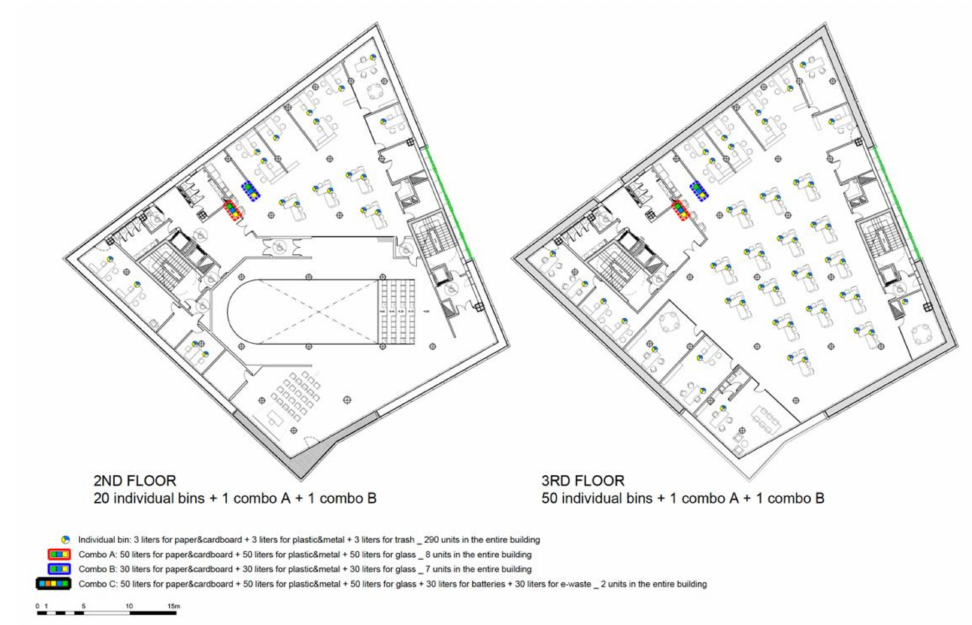
Figure 13. Location of waste collection points according to type of use and workstations. Upper floor of the Plenary Hall (first floor). Office type floor (Third Floor). Source: Castaño & Associates. LEED Rating System Report